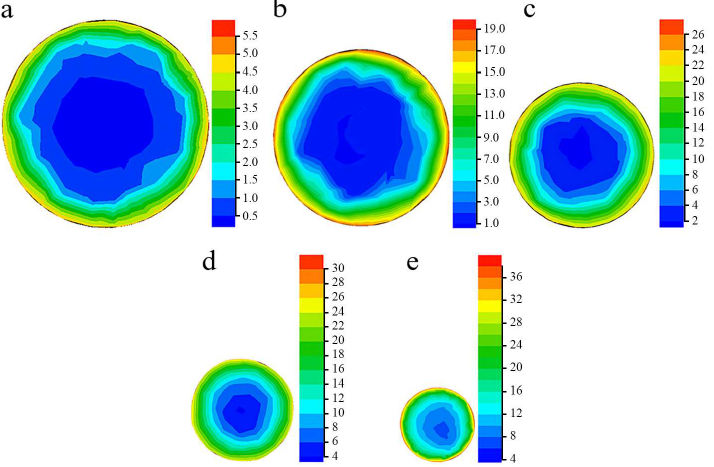
Figure 8. Effect of swaging with a strain of ( a ) 20%, ( b ) 40%, ( c ) 60%, ( d ) 80%, and ( e ) 95% on strain distribution in the transverse cross section.